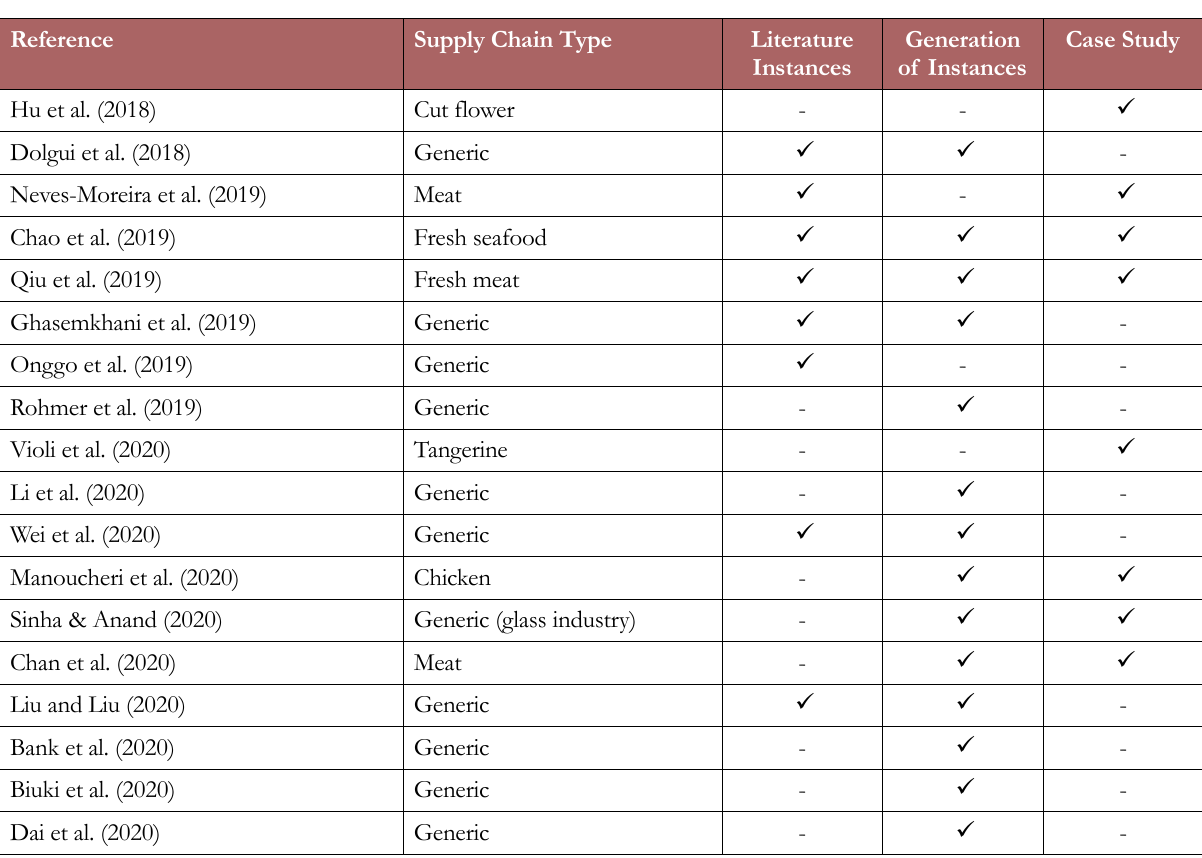
Table 12. Approach